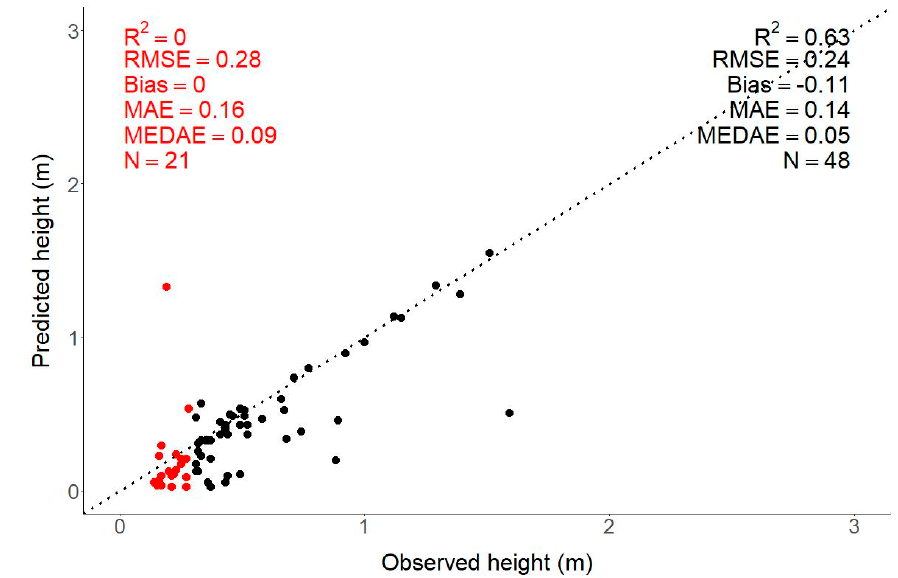
Figure 2. Scatterplot of observed (ground-measured) versus predicted heights in the best result for seedlings >30 cm (0.35 cm GSD, leaf-off, DIPC TIN ), including accuracy metrics (in black). The red dots represent seedlings ≤ 30 cm in this dataset, which were used only for the small-seedling analysis (corresponding accuracy metrics in red). MAE = mean absolute error; MEDAE = median absolute error.